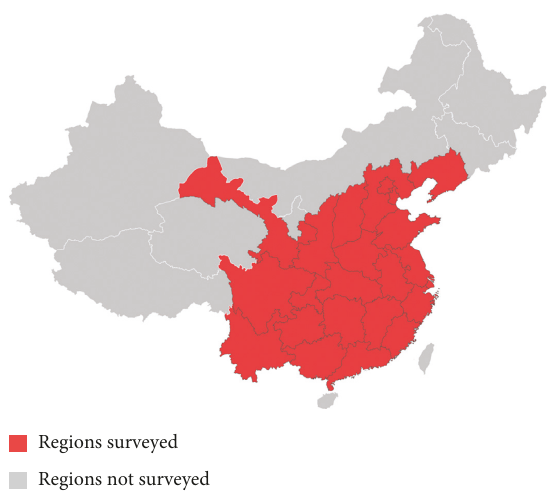
Figure 2: Locations of surveyed 23 regions in